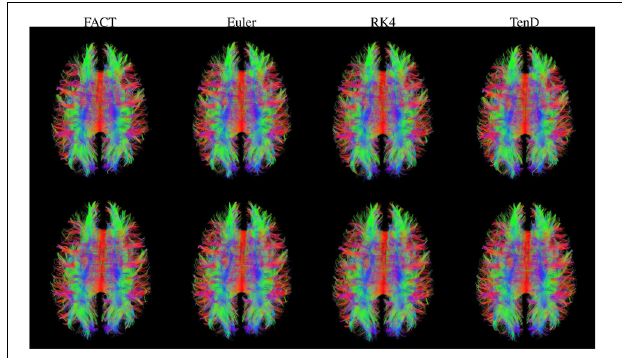
FIGURE 3 | Fiber tracts generated using each method are illustrated for both time points in a single subject. For visualization, tract sets are sampled to display 5% of the tracts at 25% opacity. Tract points are colored to illustrate local streamline